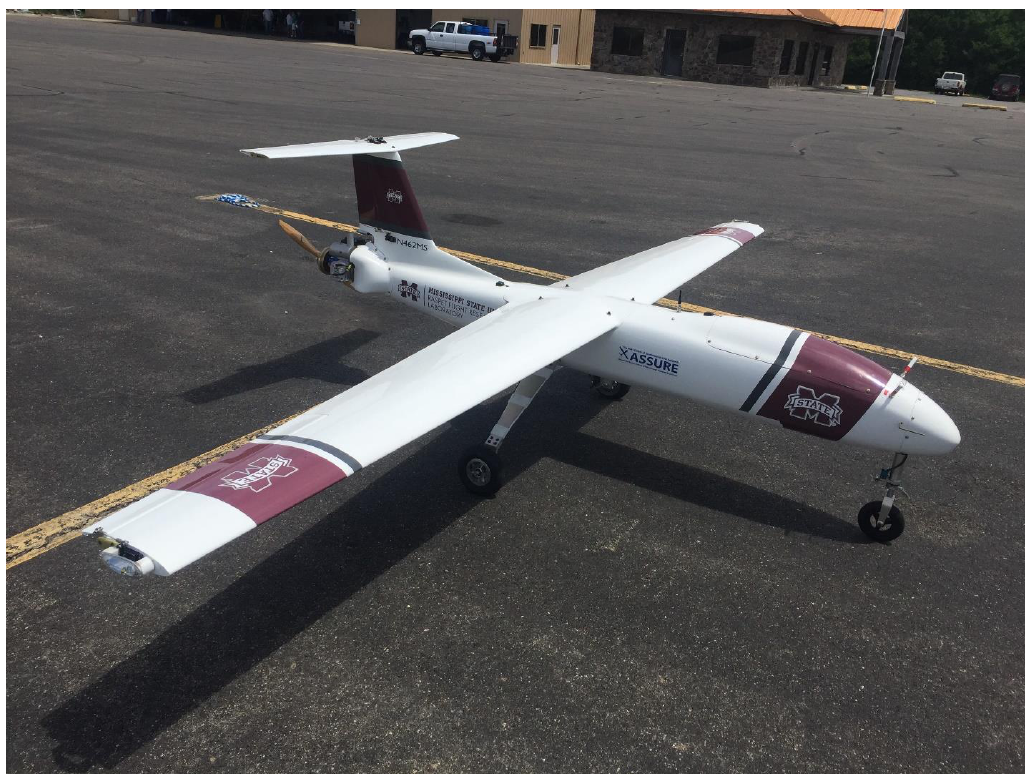
Figure 1. The Griffon Outlaw G2E fixed-wing Unmanned Aerial Vehicle (UAV) used in the study. Figure 1. The Gri ff on Outlaw G2E fixed-wing Unmanned Aerial Vehicle (UAV) used in the